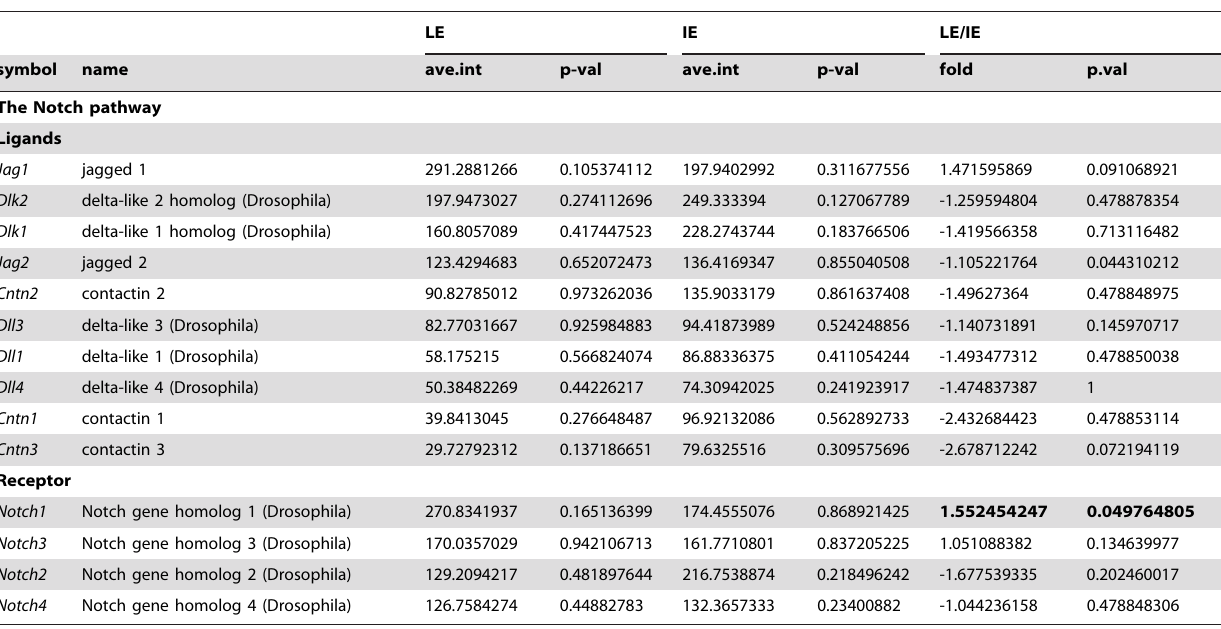
Table 9. Expresison of genes in the Notch pathways